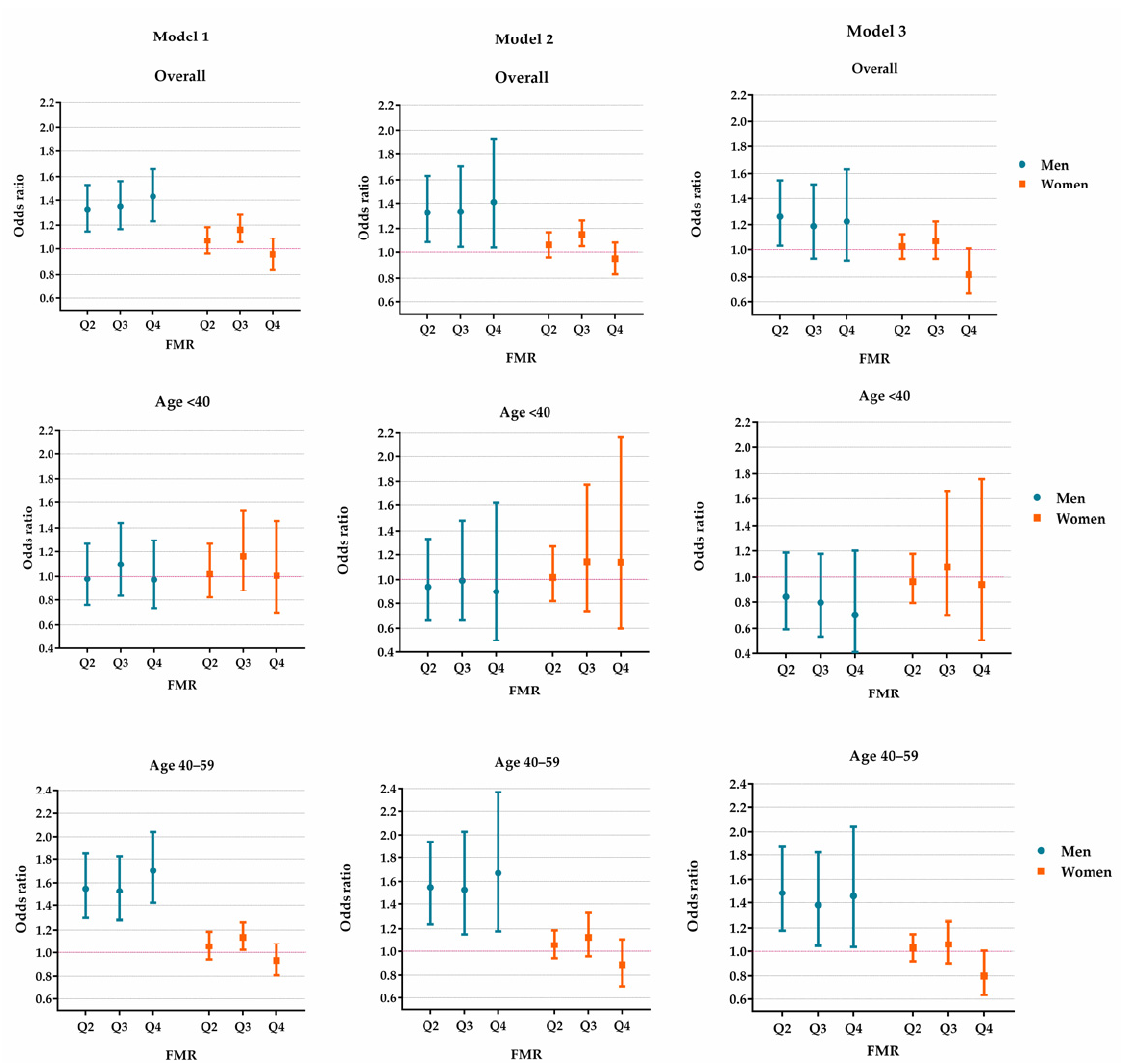
Figure 3. The effect of FMR on reduced eGFR in the study population aged 20–59. Model 1 was adjusted for age, rural/urban location, educational level, alcohol drinking status, smoking status, hypertension, diabetes and dyslipidemia. Model 2 was additionally adjusted for body mass index based on Model 1. Model 3 was additionally adjusted for hyperuricemia based on Model 2. FMR: fat-to-muscle ratio. Q2–Q4: the values fall in the 25–49th, 50–74th and 75–100th centiles of